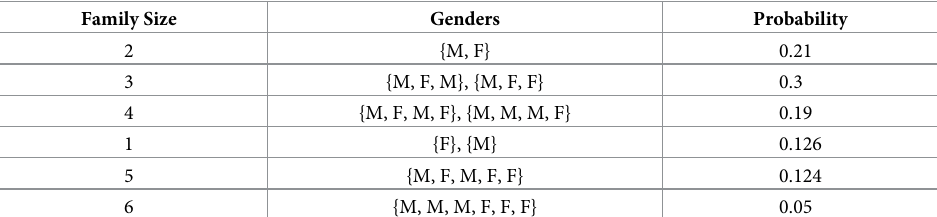
Table 5. Set of family patterns and the probability of their occurrence (M: male, F: female, {}: A family gender pat- tern). Any other arbitrary family pattern can be easily defined in Pyfectious. For brevity, the age and the health condi- tion of the family members are excluded from this table. They are sampled from a truncated normal distribution for every family member. Family